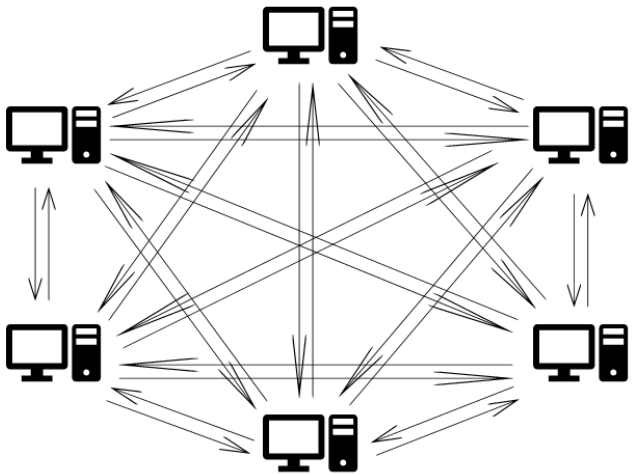
Figure 3. Network simulation infrastructure. Table 1. Systems configuration. Device Configuration System